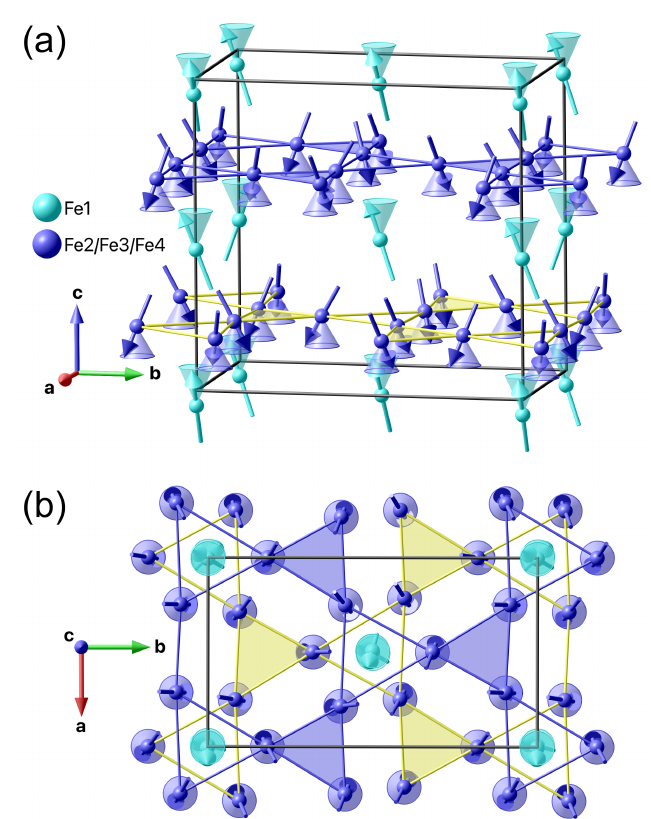
Figure 8: (a) Perspective view of the conical ferrimagnetic structure in CaBaFe O 4 7 at 15 K. Only the magnetic ions on the triangular (light blue) and hexagonal sites (dark blue) are shown. The conical envelope of the magnetic moments as well as bonds between Fe ions in the kagome planes are drawn as a guide to the eye. The kagome plane at z ∼ 0.2 is emphasized in yellow in order to be distinguished from the one at z ∼ 0.7. T triangles are open, while T triangles are filled. (b) View along 1 2 the c axis emphasizing the rotation of the magnetic moments within the a - b plane. The spin rotation plane is emphasized by disks in the respective colors. The trian- gular plaquettes T of kagome Fe spins reveal a 120 ◦ configuration. The same spin 1 orientation and triangular chirality is found for the triangle at ∆ z = 0.5 indicating a ferromagnetic coupling between two